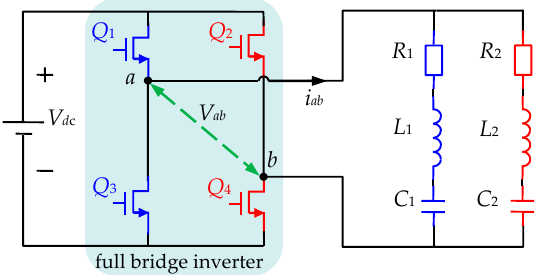
Figure 4. The topology of dual-frequency PHM inverter.